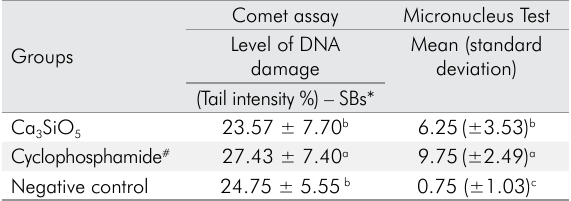
Table. Level of DNA damage (tail intensity %) and frequency of micronuclei in bone marrow cells treated with Ca cyclophosphamide and in untreated cells (negative control).